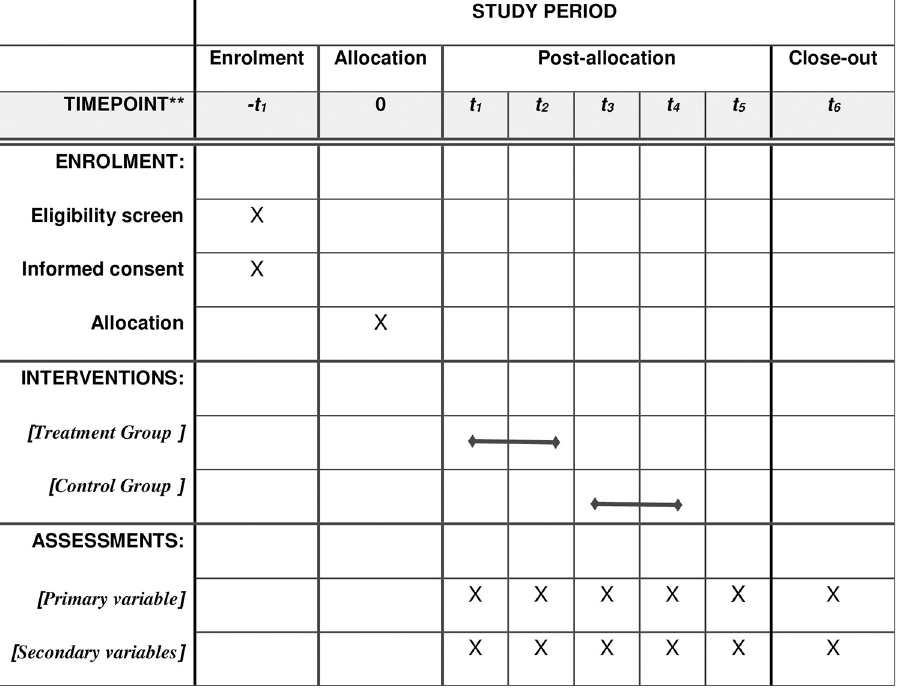
Fig 1. SPIRIT schedule of enrolment, intervention and assessments. Note: -t1, Eligibility screen, Informed consent; t1, baseline assessment; t2, post 8-week intervention; t3, 3-month follow-up; t4, 6-month follow-up; t5, 12-month follow-up; t6, participants complete treatment and follow-up in both the TG and the CG.